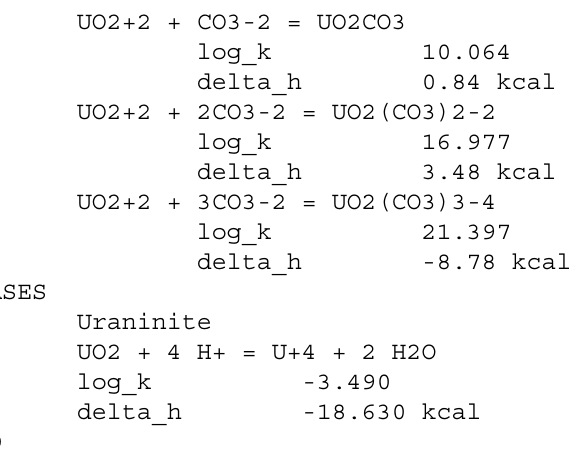
----- Example 1.--Add uranium and speciate seawater. ------------------------------------------- Beginning of initial solution calculations.